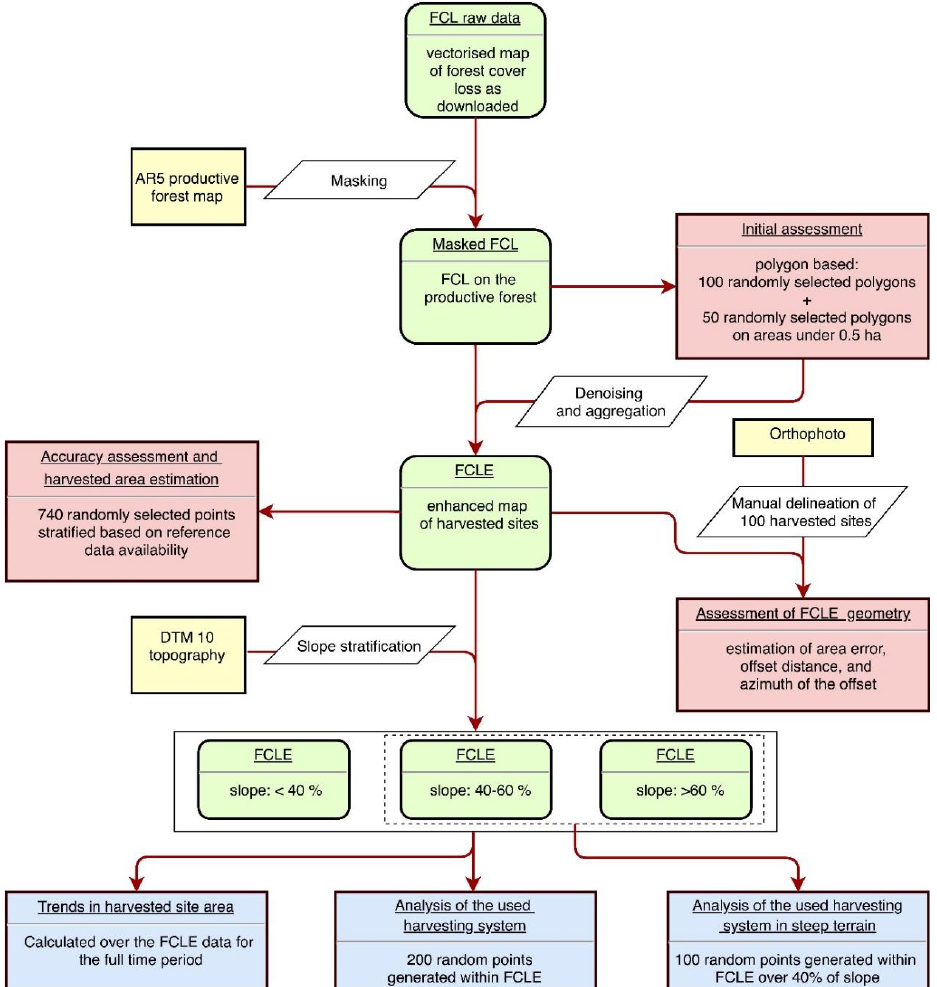
Figure 3. Workflow of the main datasets being analysed (green rounded boxes), other data sources used for masking and stratification (yellow rectangles), intermediate processing (parallelograms), assessment of the forest cover loss (FCL) and forest cover loss enhanced (FCLE) maps (red rectangles), and assessment of harvesting activities (blue rectangles).